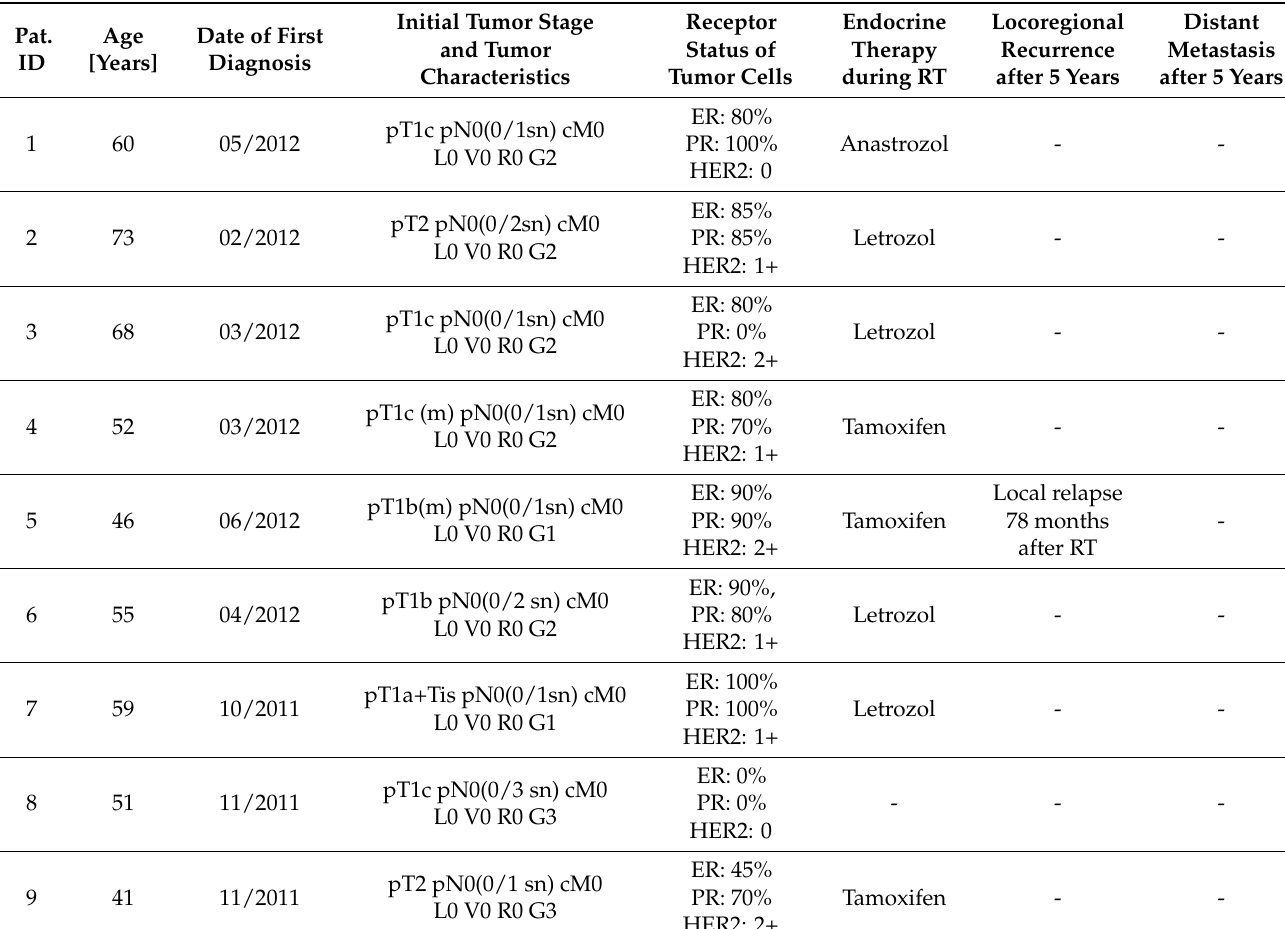
Table 2. Patient